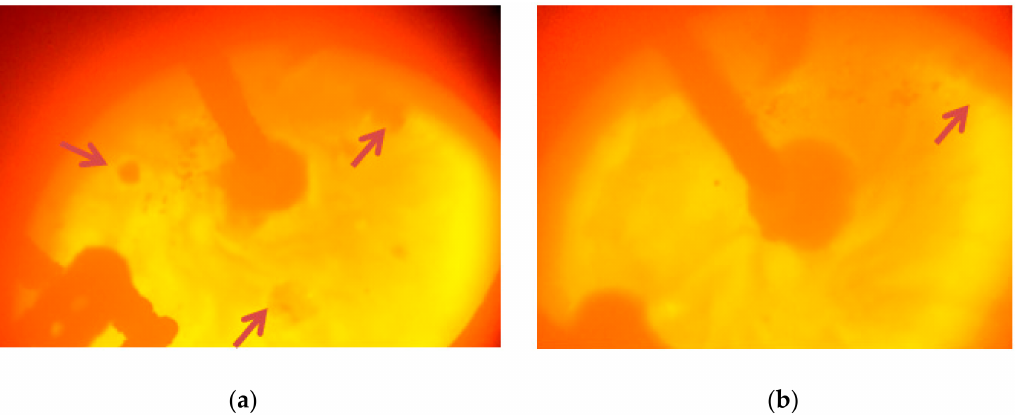
Figure 1. Bubble evolution during didymium electrolysis in: ( a ) stable operational conditions; ( b ) unstable operational